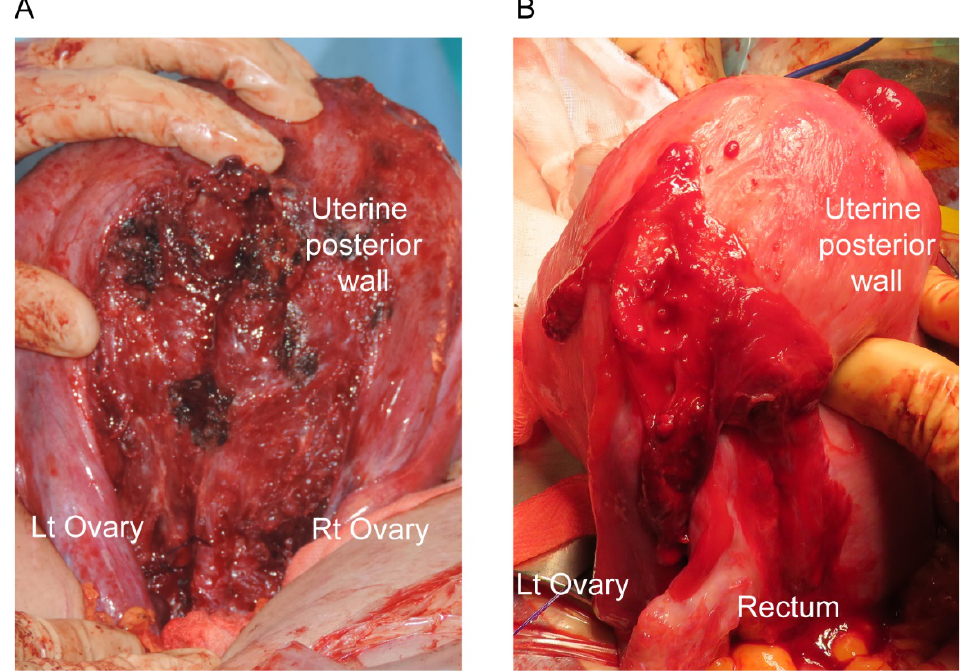
Figure 1. Intraoperative images during cesarean delivery of patients with endometriosis. ( A ) Intraoperative image of a patient with placenta previa (PP) and endometriosis who had a history of laparoscopic surgery for endometriosis showing the uterine posterior wall that was actively bleeding; it took a long time to control the bleeding. ( B ) Intraoperative image of a PP patient with endometriosis, but without a history of surgery for endometriosis. Strong adhesions were observed between the left posterior uterine wall and the rectum. Lt, left; Rt, right.